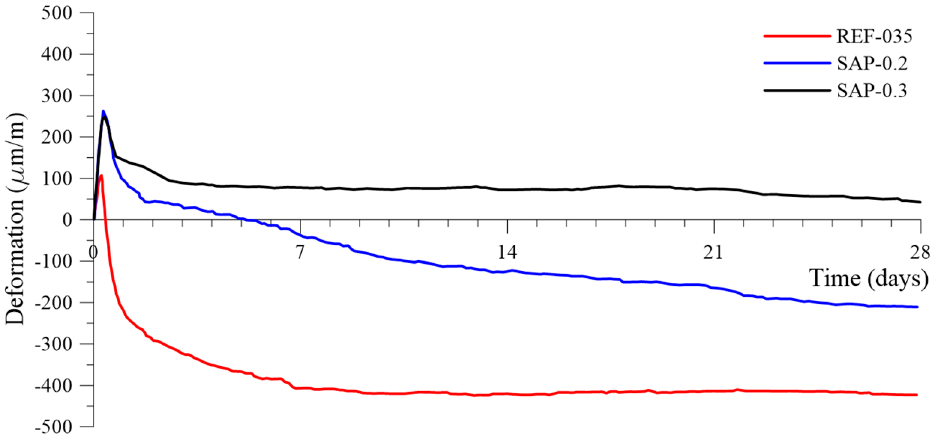
Figure 6. Autogenous strain (um/m) for cement mortar mixtures without fibers w/c (total) of 0.35, with SAP additions of 0.2% and 0.3%, determined from time zero up to 28 days.